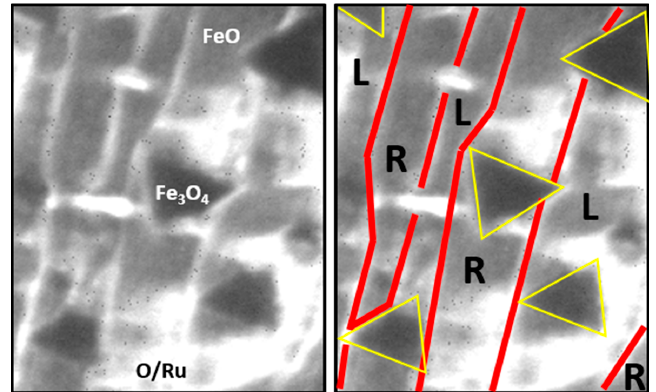
Figure 4. Excerpt from a LEEM image of iron oxides on Ru(0001) showing the 180 ◦ rotation of triangular Fe 3 O 4 (111) islands on adjacent monoatomic terraces of the Ru(0001) substrate. The raw image is shown on the left, while the right hand side shows the same image with marked island contours (in yellow) and substrate monoatomic step edges (in red). “L” and “R” indicate terraces with ‘left-oriented’ and ‘right-oriented’ islands, respectively.